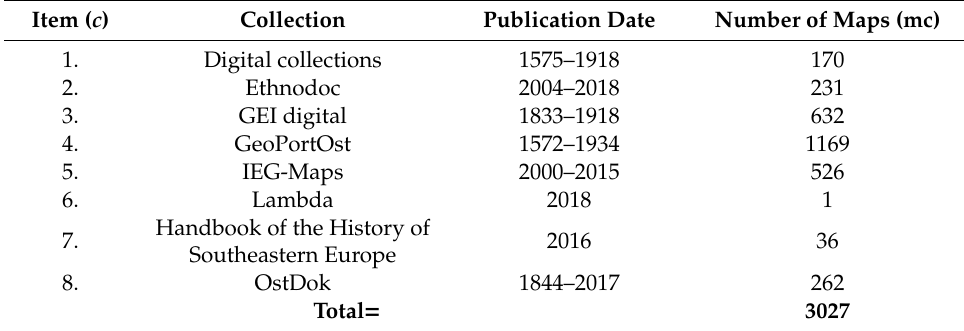
Table 2. Collections in the GeoPortOst